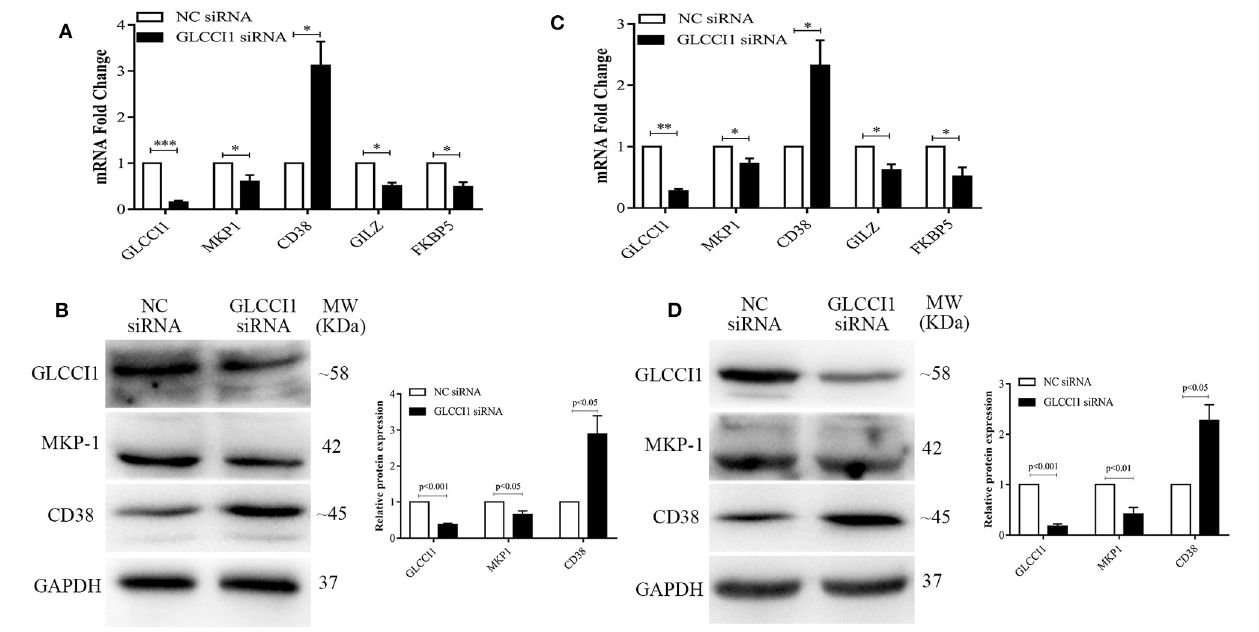
FIGURE 2 | GLCCI1 deficiency results in glucocorticoid insensitivity in Beas2B and A549 cells. OVA and Dex were used to stimulate Beas2B and A549 cells in the presence or absence of GLCCI1 siRNA. (A) RT-PCR analysis of GLCCI1, MKP-1, and CD38, GILZ and FKBP5 mRNA expression in Beas2B cells. (B) Representative images and relative protein levels of GLCCI1, MKP-1, and CD38 assessed by WB in Beas2B cells. (C) RT-PCR analysis of GLCCI1, MKP-1, and CD38, GILZ and FKBP5 mRNA expression in A549 cells. (D) Representative images and relative protein levels of GLCCI1, MKP-1, and CD38 assessed by WB in A549 cells (D) . Data are presented as means ± SEM of more than three independent experiments. * P < 0.05, ** P < 0.01, *** P < 0.001. Intergroup differences as determined by Student’s t